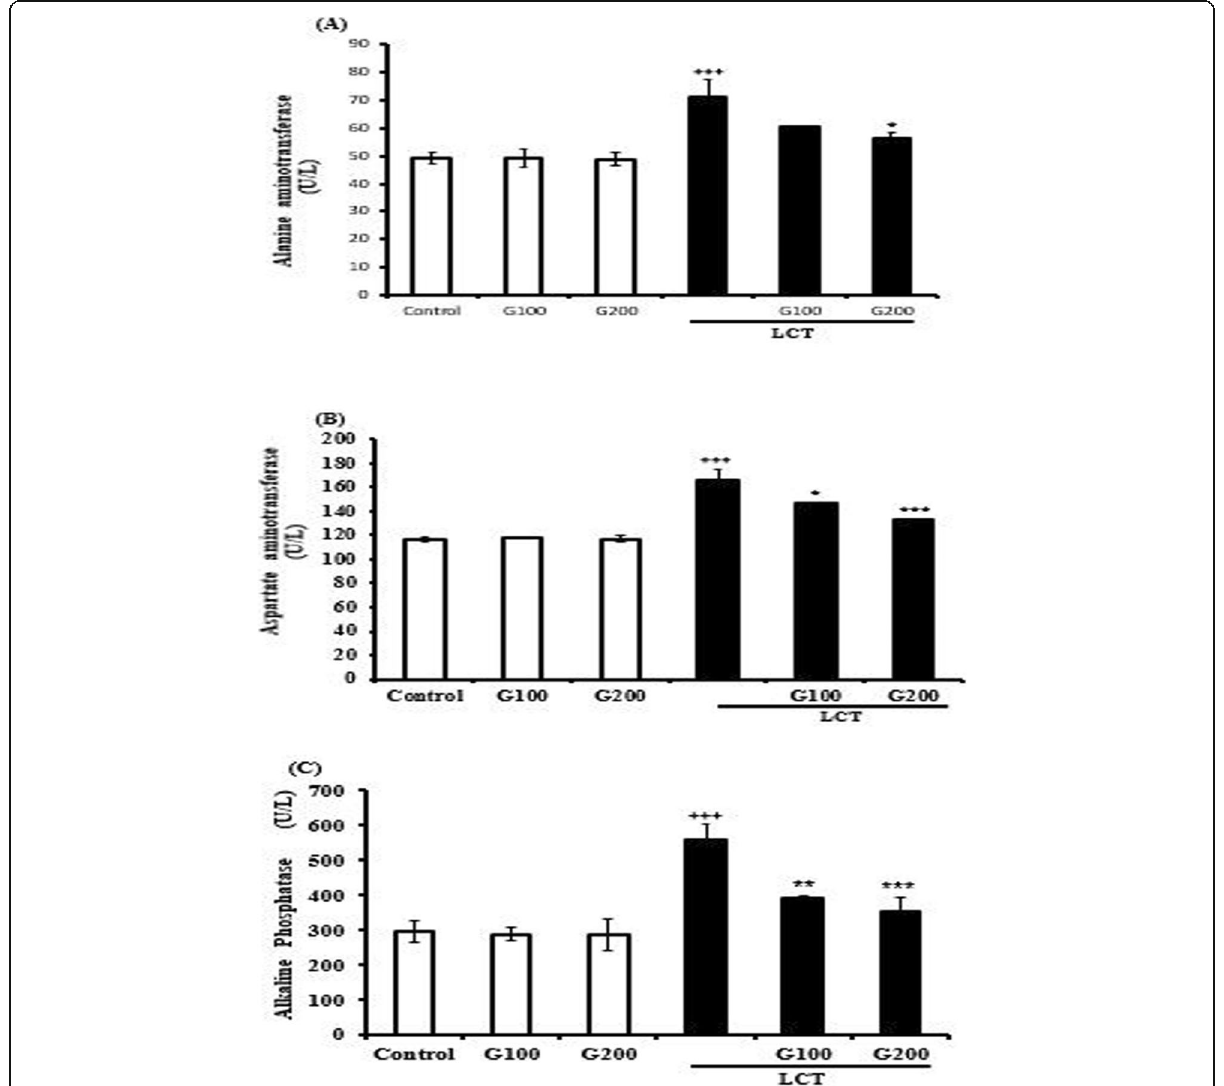
Fig. 2 Effect of Panax ginseng on lambda cyhalotherin-induced changes in a alanine aminotransferase (U/L), b aspartate aminotransferase (U/L), and c alkaline phosphatase (U/L). The results were expressed as mean ± SE ( N = 6). Where G100, 100 mg Panax ginseng ; G200, 200 mg Panax ginseng ; LCT, lambda cyhalotherin administered rats. Values were considered significantly different at +++ P < 0.001 versus control group and * P < 0.05, ** P < 0.01, *** P < 0.001 versus LCT